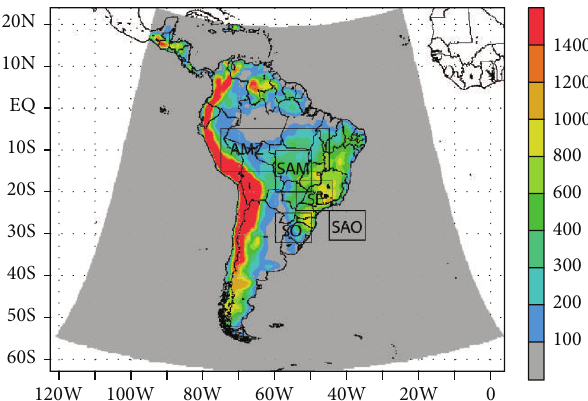
Figure 1: Subdomains used to validate the RegCM3 simulations: Amazon (AMZ), the area used in different studies to identify the lifecycle of the South American monsoon (SAM), southeastern Brazil (SE), southern Brazil (SO), and western South Atlantic Ocean (SAO). South America topography (m) is also shown in the